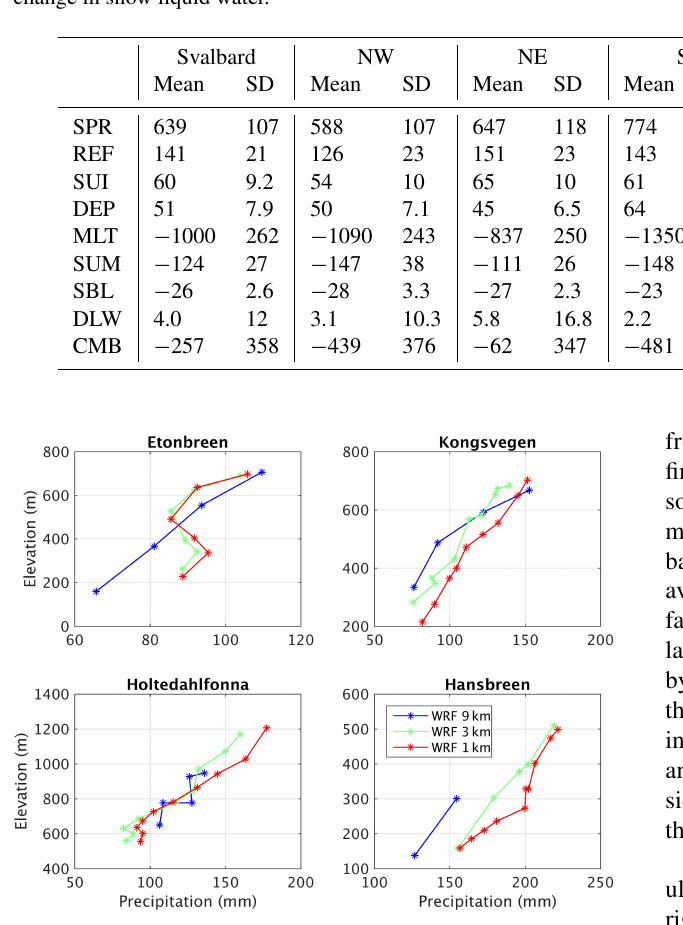
Figure 8. Precipitation during October 2007 at stake locations with 9km (blue), 3km (green), and 1km (red) grid